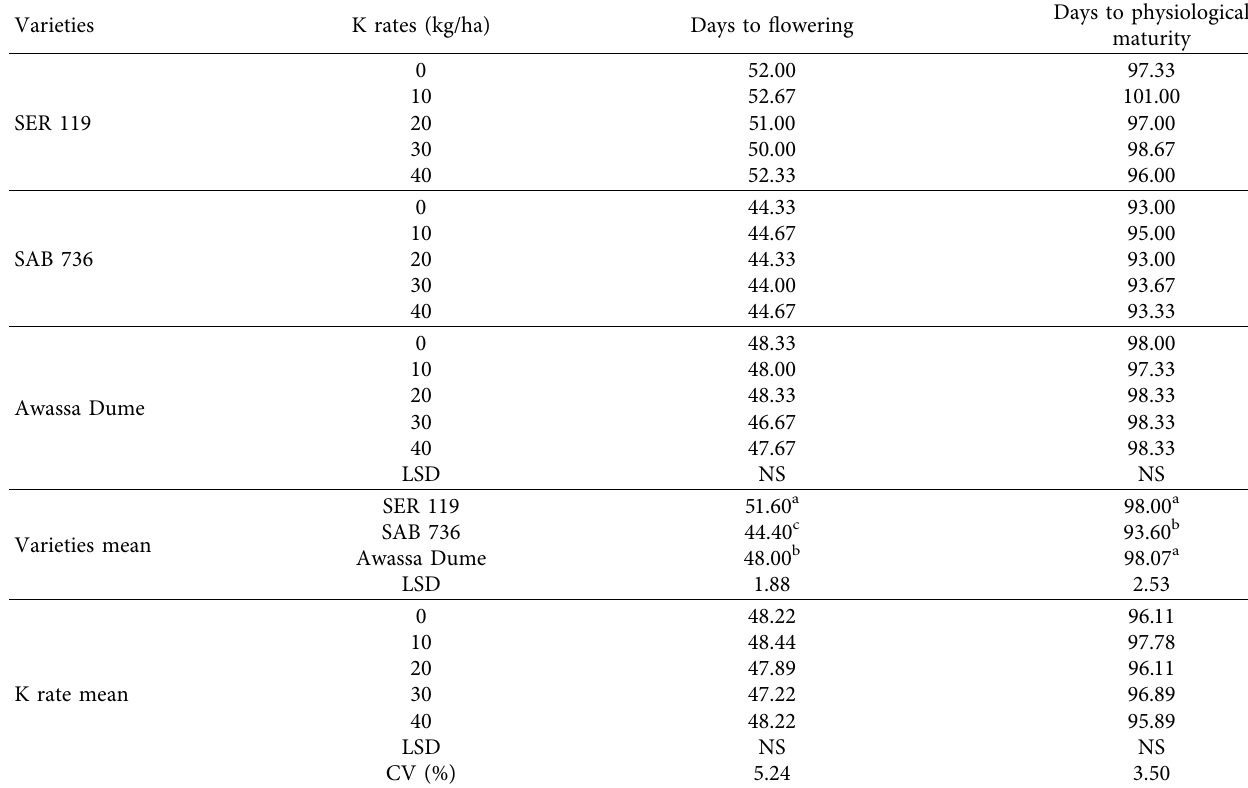
Table 1: Days to fowering and physiological maturity as afected by varieties and K rates during 2019/20 cropping